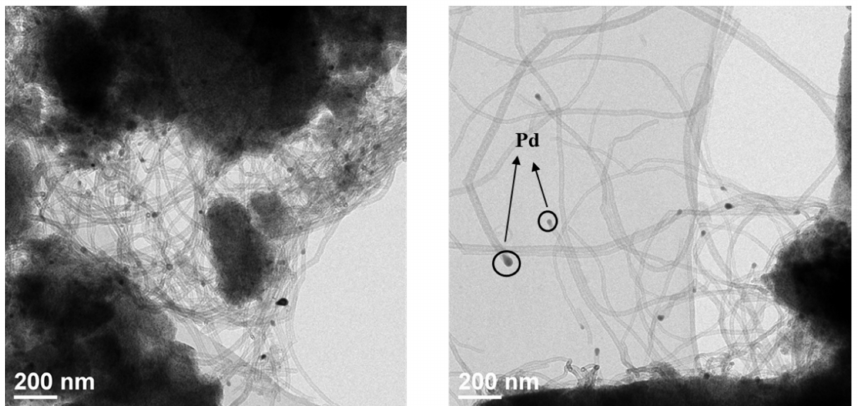
Figure 11. The TEM images of the spent 700Ar-Du1800-Pd catalyst after the DRM tests in a recirculat- ing batch